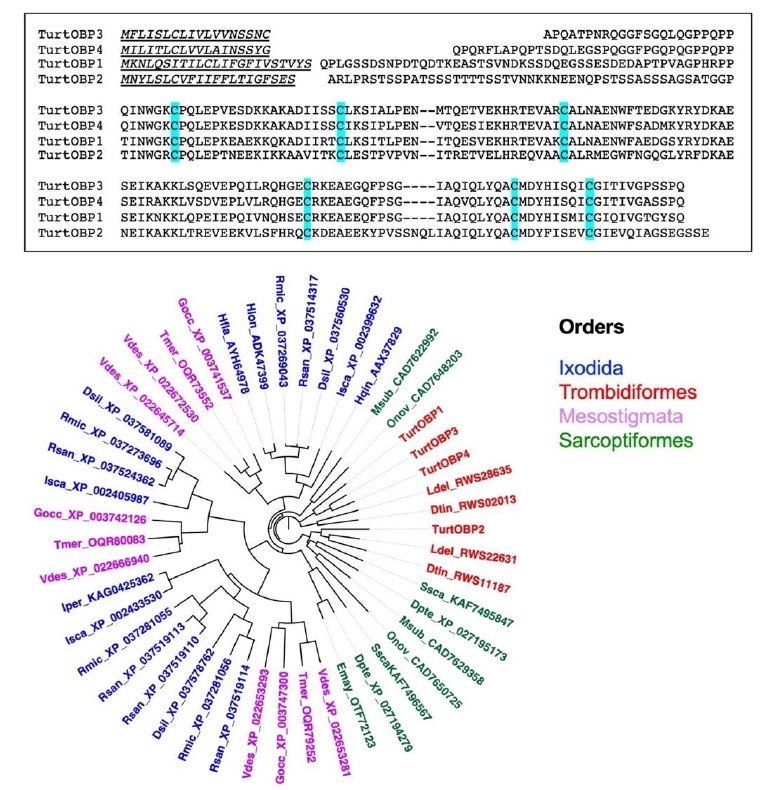
Figure 1. Upper : Alignment of the four OBPs of T. urticae . Conserved cysteines are highlighted. Lower : Phylogenetic tree of the four OBPs of T. urticae and their orthologs in ticks and mites. The sequences used to construct the tree are reported in Supplementary Table S1. The tree was built using the neighbor-joining method and Kimura distances on the sequences aligned with ClustalW and default parameters. The tree was visualized with the software FigTree, version 1.4.2 (https://github.com/rambaut/figtree/releases (accessed on 12 March 2021)).